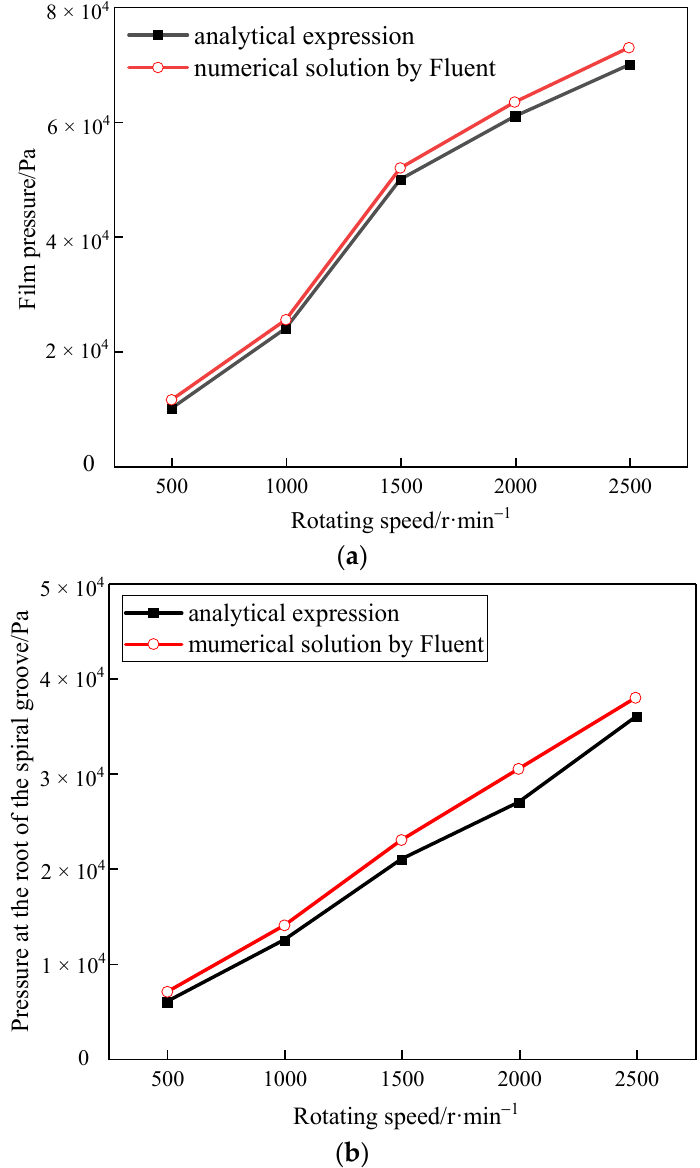
Figure 5. The verification of the calculation method: ( a ) The spiral groove verification; ( b ) The diffuser groove verification.